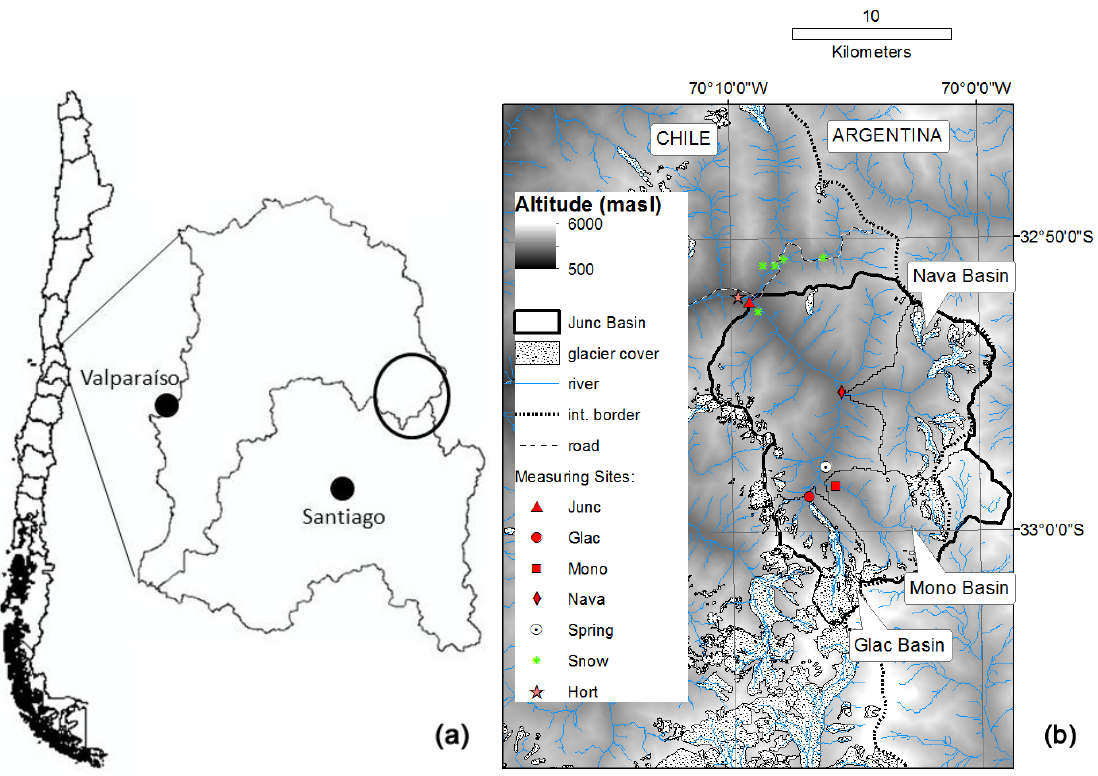
Fig. 1. (a–b) Study area with locations of sampling points. Junc = Juncal River sampling site and discharge gauge. Glac/Mono/Nava = sampling site for tributaries (the Glac headwater represents glacier melt). Spring = sampled spring. Snow = Altitude gradient of snow samples. Hort = Hornitos meteorological station.